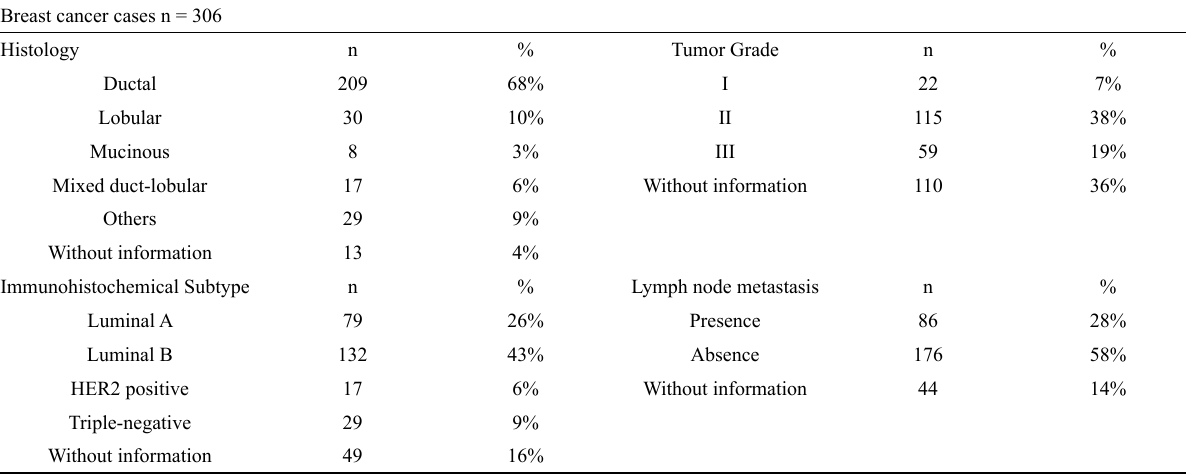
Table 1 – Clinical and Histopathological Data of Breast Cancer patients. Breast cancer cases n = 306